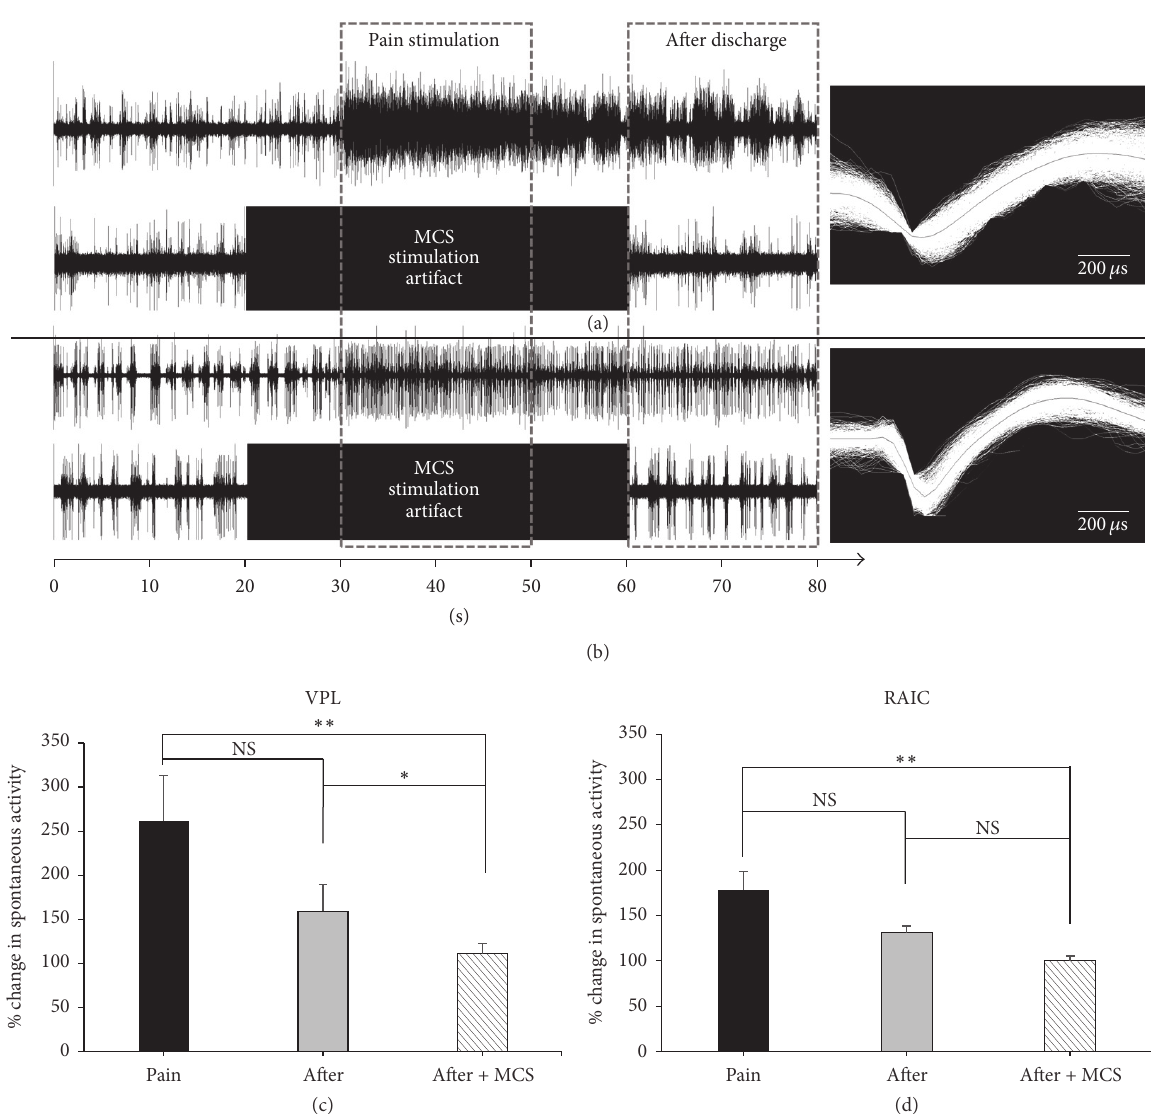
Figure 6: Electrophysiological recordings showing firing rate changes upon mechanical stimulation with 300 g von Frey filament and motor cortex stimulation. Firing rate at the ventral posterolateral nucleus (VPL) markedly increased upon pain stimulation and the trend persisted after discharge, but the postdischarge firing rate decreased when MCS was applied (a). Similarly, firing rate at the rostral agranular insular cortex (RAIC) markedly increased upon pain stimulation and the trend persisted after discharge, but the postdischarge firing rate decreased when MCS was applied (b). Each VPL and each RAIC wave form are presented on the right. Percentage changes in spontaneous neuronal activity, recorded from VPL (c) and RAIC (d), were decreased after MCS on state. And these changes were statistically significant compared with mechanical stimulation without MCS ( 𝑝 < .05 ). Statistical analysis was made using Friedman test followed by post hoc Dunn’s multiple comparison test. ∗∗ 𝑝 < .01 ; ∗ 𝑝 < .05 ; NS = not statistically